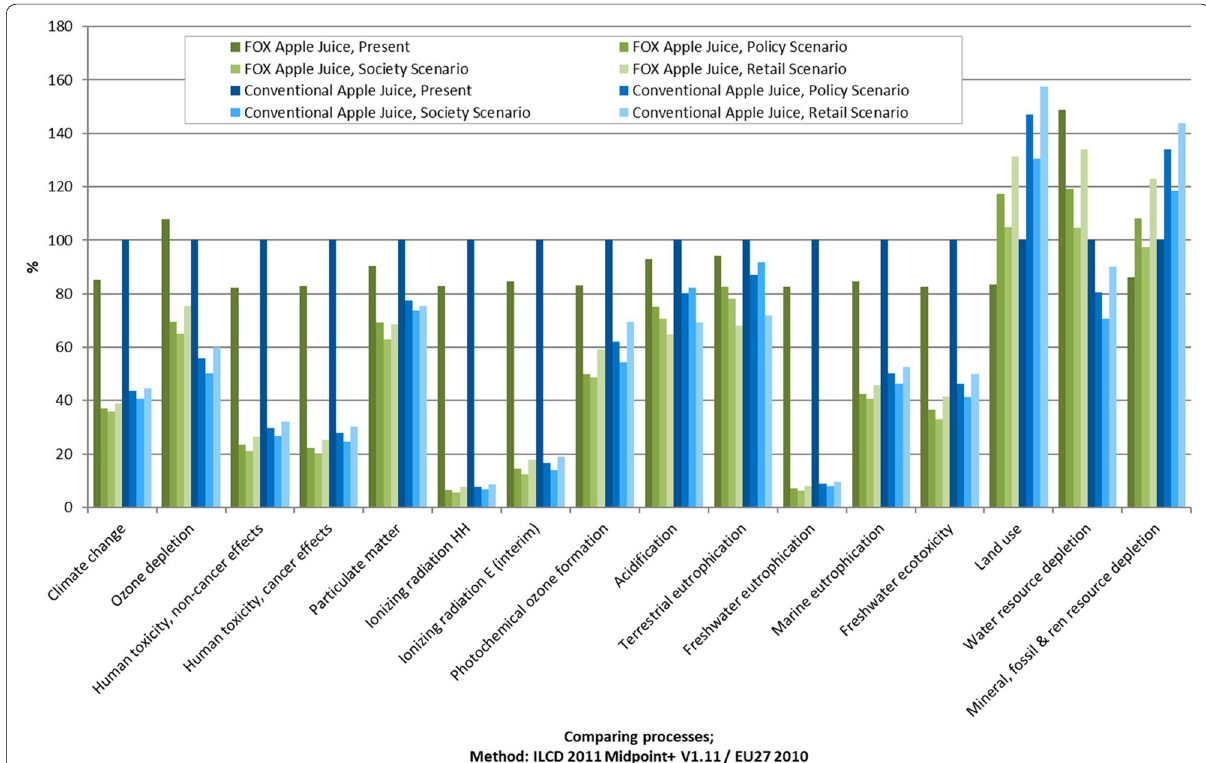
Fig. 4 Relative contributions to the environmental impact with the conventional apple juice in the present as the reference value at 100%; characterized factors, method: ILCD 2011 Midpoint +